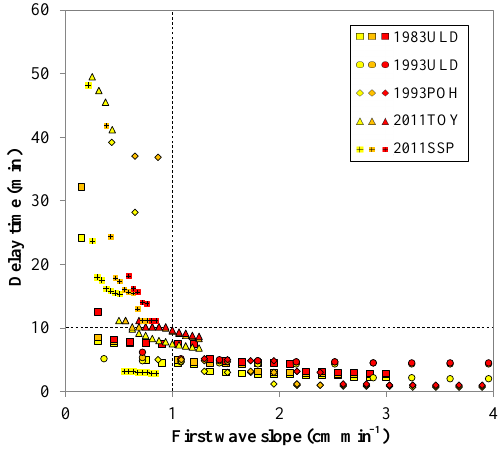
Figure 14. Performance test of the tsunami detection algorithm. The delay times are depicted distinctly depending on the types of synthetic tsunamis: 1983 ULD (rectangle), 1993 ULD (circle), 1993 POH (diamond), 2011 TOY (triangle), and 2011 SSP (cross). The types of alarms are depicted distinctly: warning (red), advisory (orange), and watch